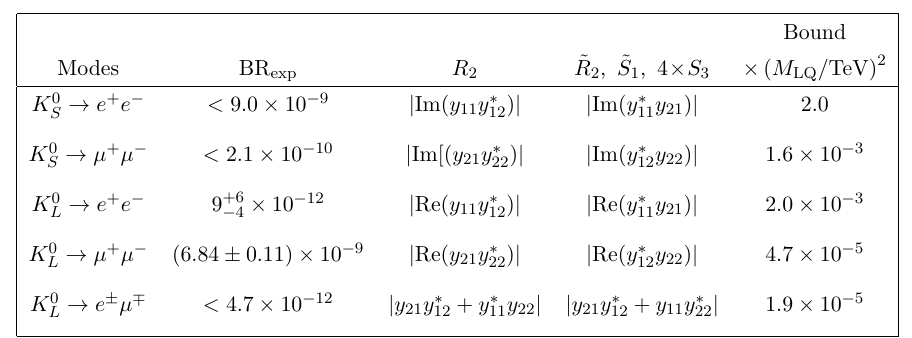
Table 8 . Limits on leptoquark couplings from leptonic kaon decays. The experimental upper bounds are at 90% C.L.